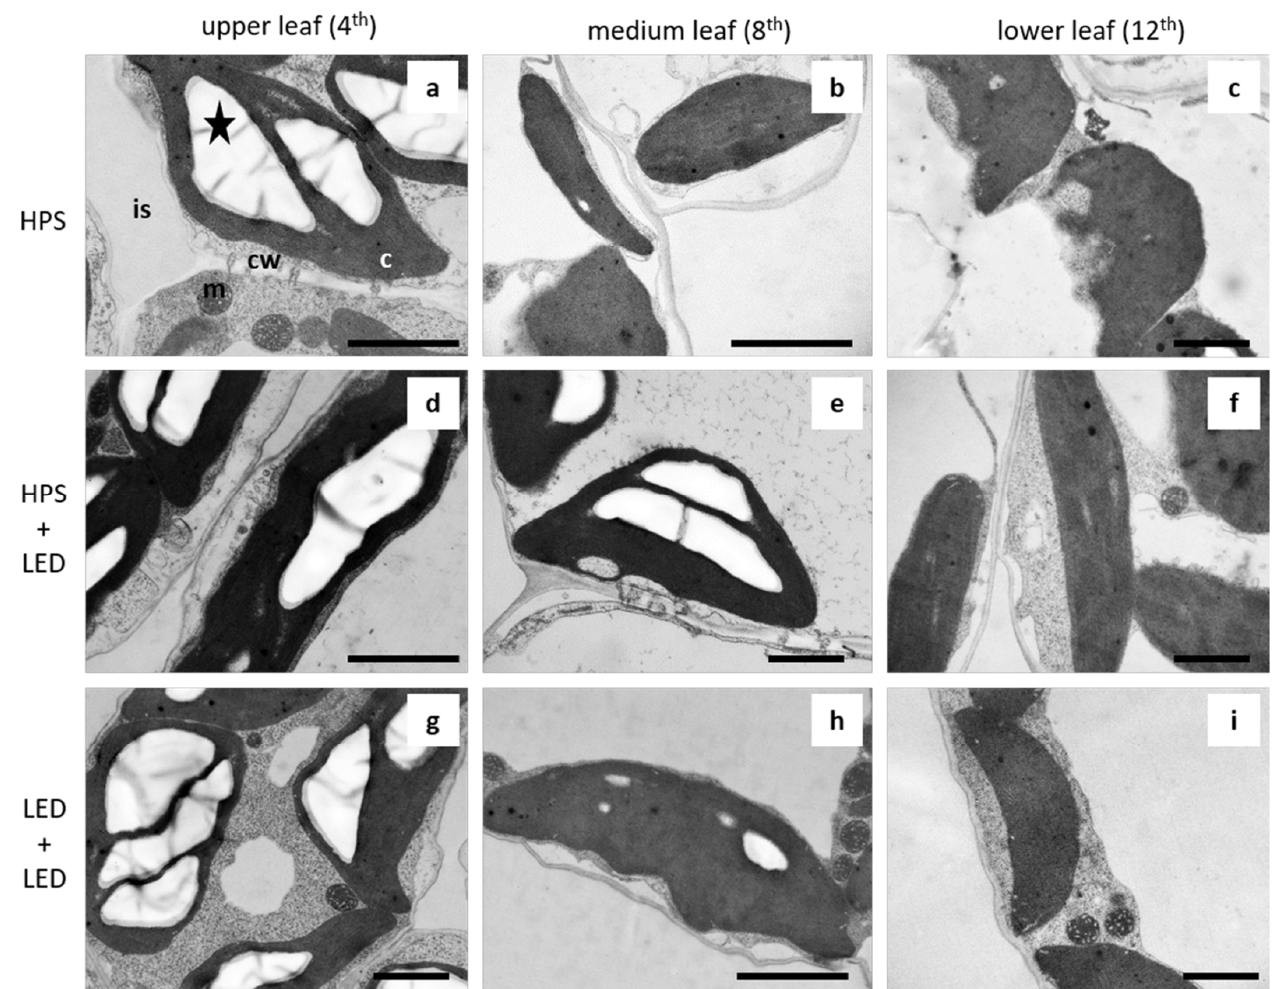
Figure 2. Electron microscopy investigations: localisation of starch granules within chloroplasts of cucumber leaves exposed to different supplemental light treatments. ( a ) HPS, upper leaf; ( b ) HPS, medium leaf; ( c ) HPS, lower leaf; ( d ) HPS + LED, upper leaf; ( e ) HPS + LED, medium leaf; ( f ) HPS + LED, lower leaf; ( g ) LED + LED, upper leaf; ( h ) LED + LED, medium leaf; ( i ) LED + LED, lower leaf. Notice that large starch granules are present only in chloroplasts of the upper leaves independently of the treatment and in the medium leaves of plants representing HPS + LED treatment. Abbreviations: c—chloroplast; cw—cell wall; is—intercellular space; HPS—high-pressure sodium lamps used as toplighting; HPS + LED—HPS toplighting and LED interlighting; LED + LED—light-emitting diode lamps used as toplighting and interlighting; m—mitochondrium; star—starch granule. Bars = 2 µm.